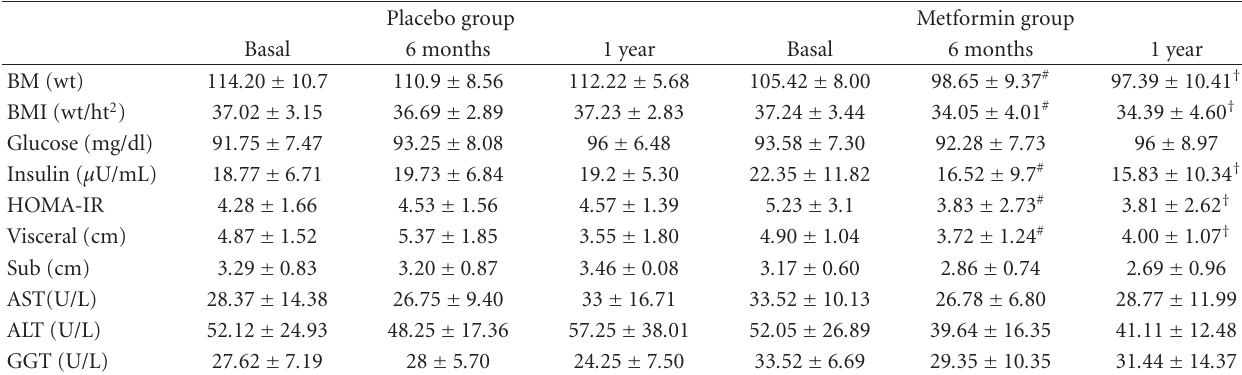
Table 1: Characteristics of adolescent obese boys measured at baseline, 6 months, and 1 year after multidisciplinary lifestyle program associated with metformin